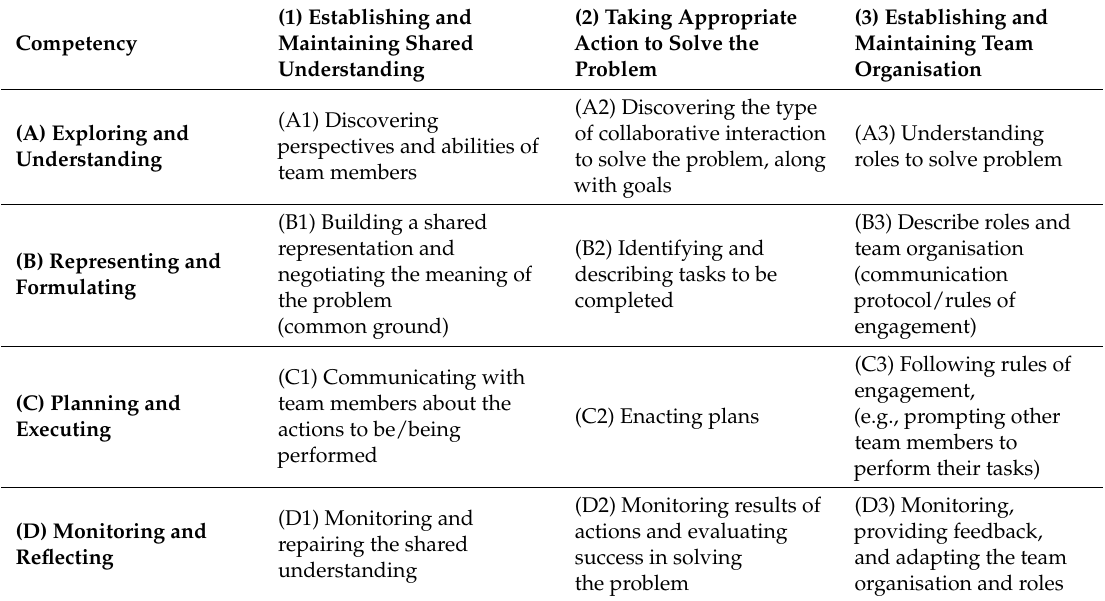
Table 1. Matrix of Collaborative Problem Solving Skills for Programme for International Student Assessment (PISA) Collaborative Problem Solving (ColPS)